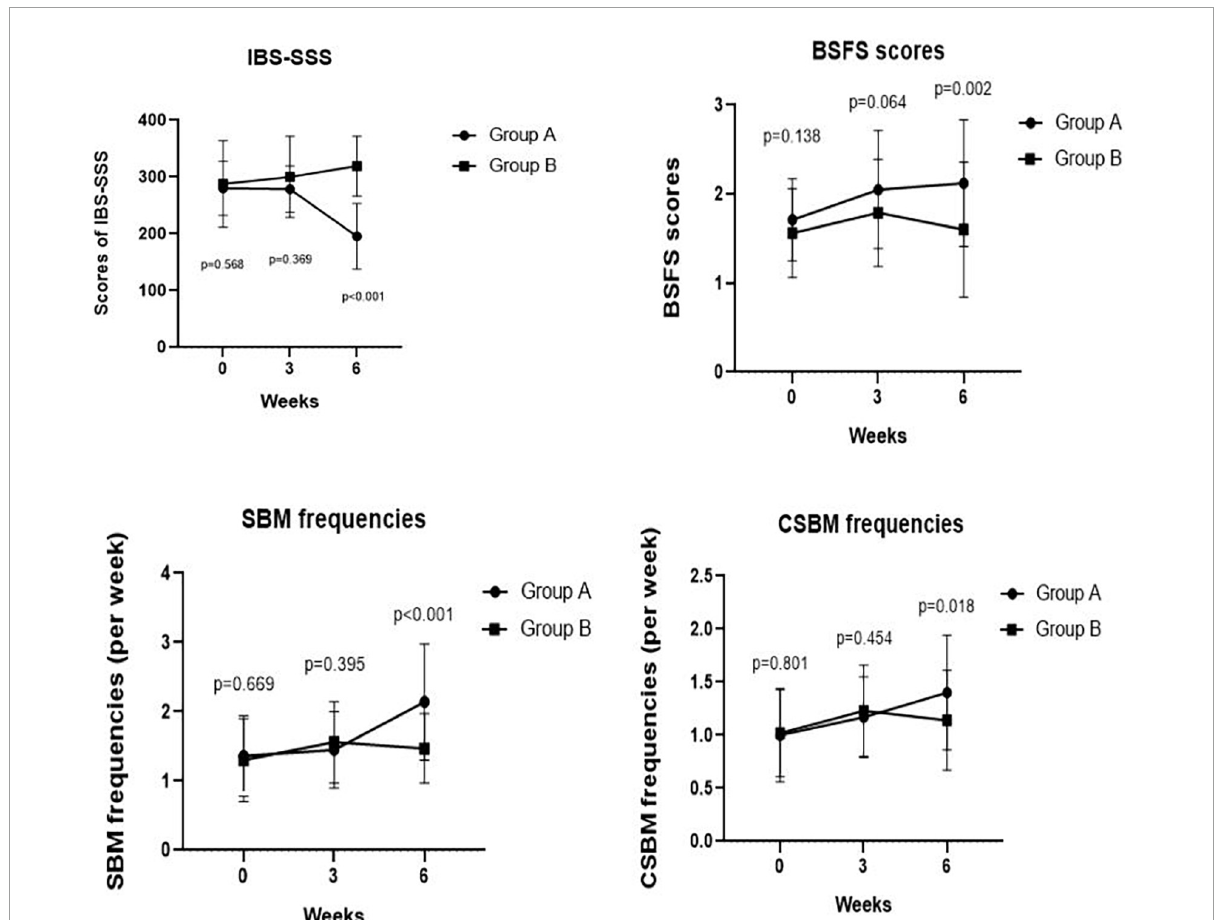
FIGURE2 Comparing IBS-SSS score, BSFS score, weekly frequency of CSBMs, and weekly frequency of SBMs pre- and post-treatment at weeks 3, 6 between Groups A and B. We found a significant difference in IBS-SSS, BSFS score, weekly frequency of SBMs, weekly frequency of CSBMs post-treatment between Groups A and B at week 6 ( p < 0.001, p = 0.002, p < 0.001, and p = 0.018, respectively).